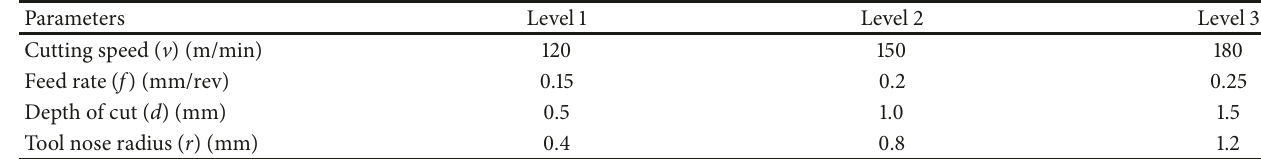
Table 1: Input parameters and their levels for turning of AISI 1045 steel.